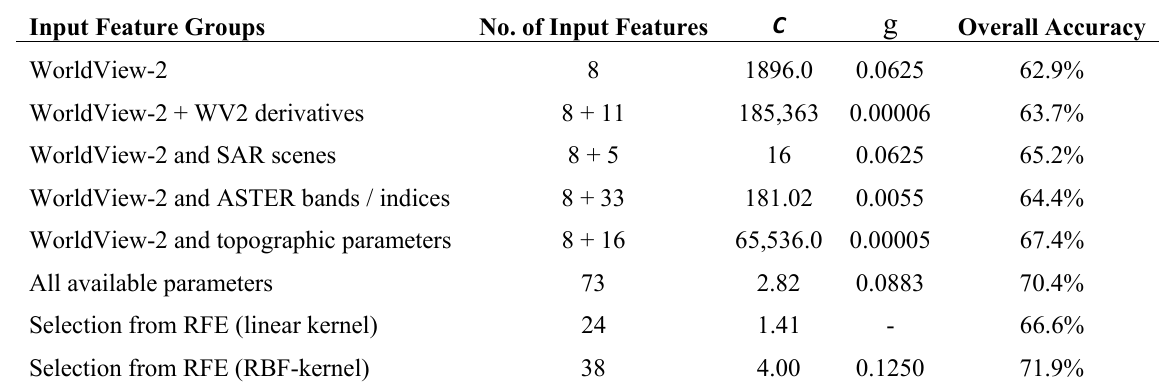
Table 6. Overall accuracies for different input feature groups. RBF, radial basis function.